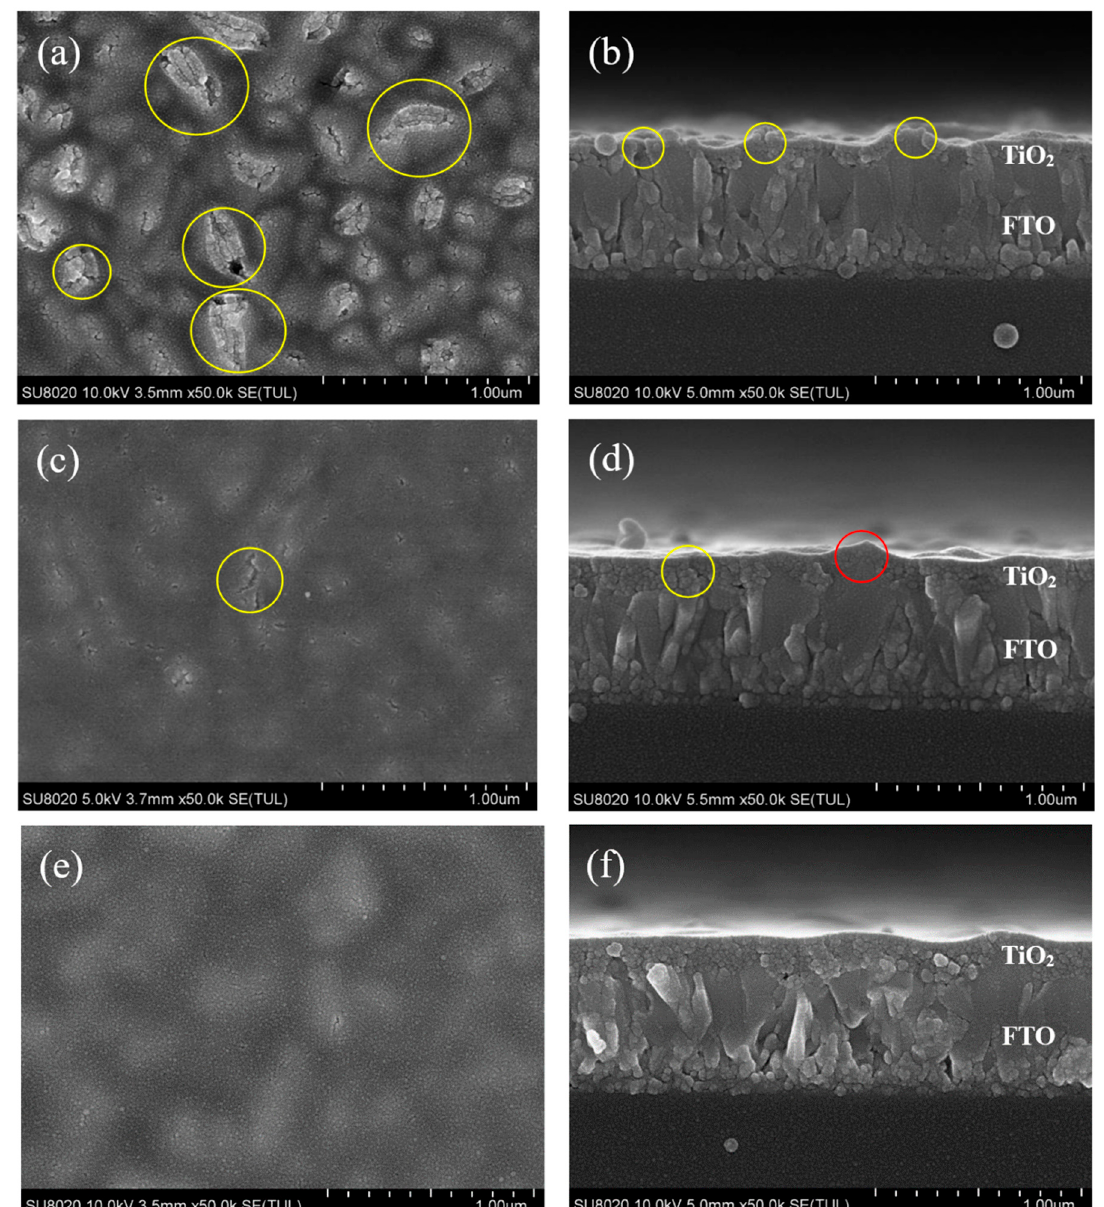
Figure 3. SEM images of TiO 2 film with different spin-coating cycles: ( a , c , e ) Top view images of TiO 2 for one, two, and three spin-coating cycles, respectively; ( b , d , f ) Cross-sectional view images of TiO 2 for one, two, and three spin-coating cycles, respectively.